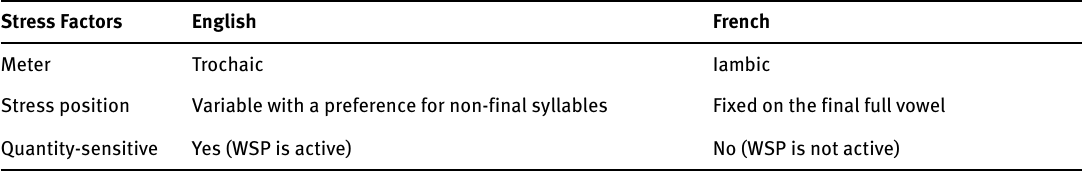
Table 1 Summary of English and French stress Stress Factors English French Meter Trochaic Iambic Stress position Variable with a preference for non-final syllables Fixed on the final full vowel Quantity-sensitive Yes (WSP is active) No (WSP is not